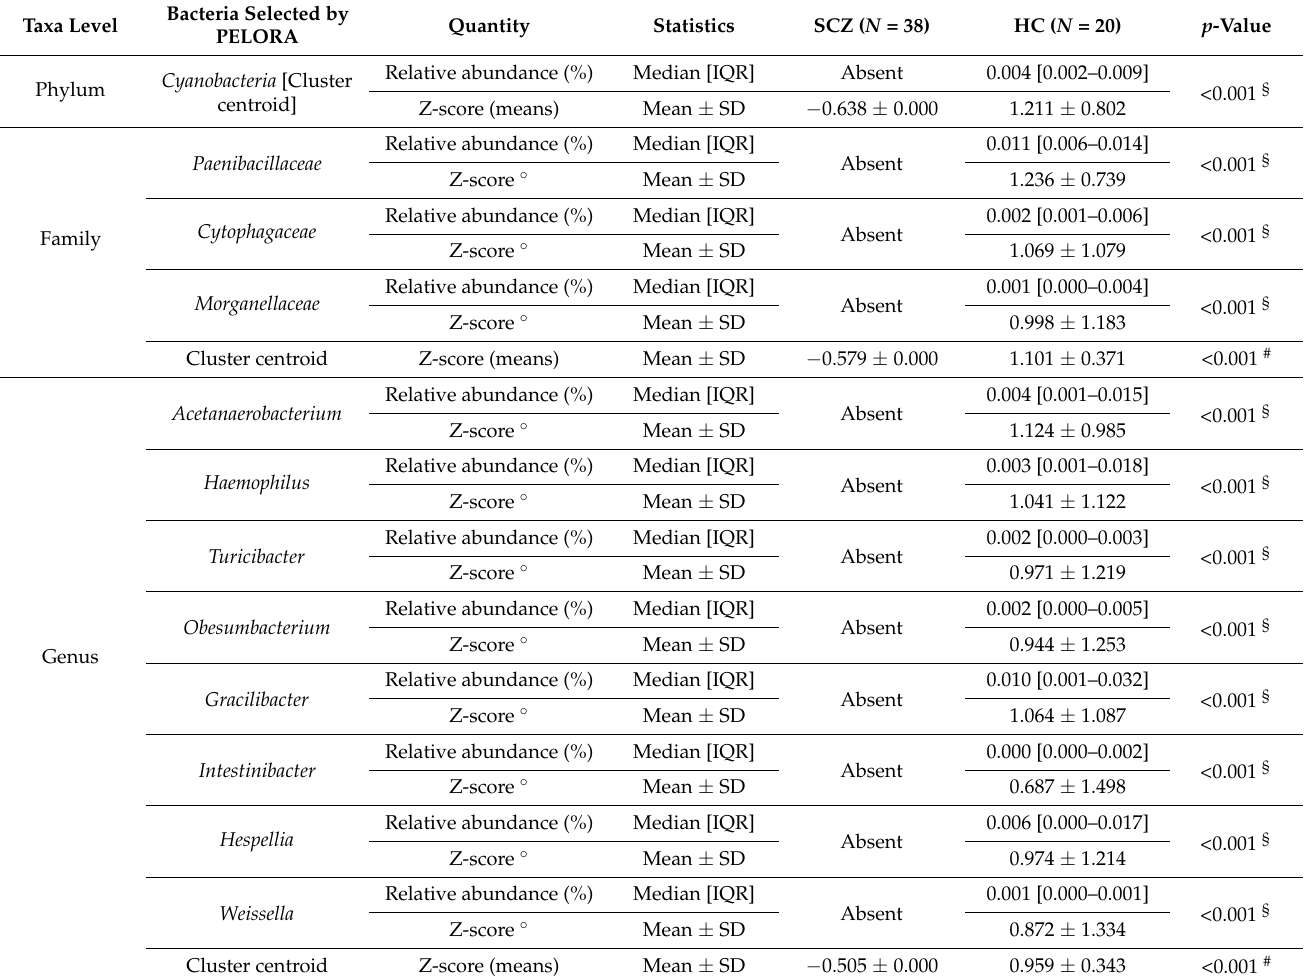
Table 2. Results from Penalized Logistic Regression Analysis (PELORA) algorithm which identify panels of bacterial populations that best discriminate patients affected by SCZ from